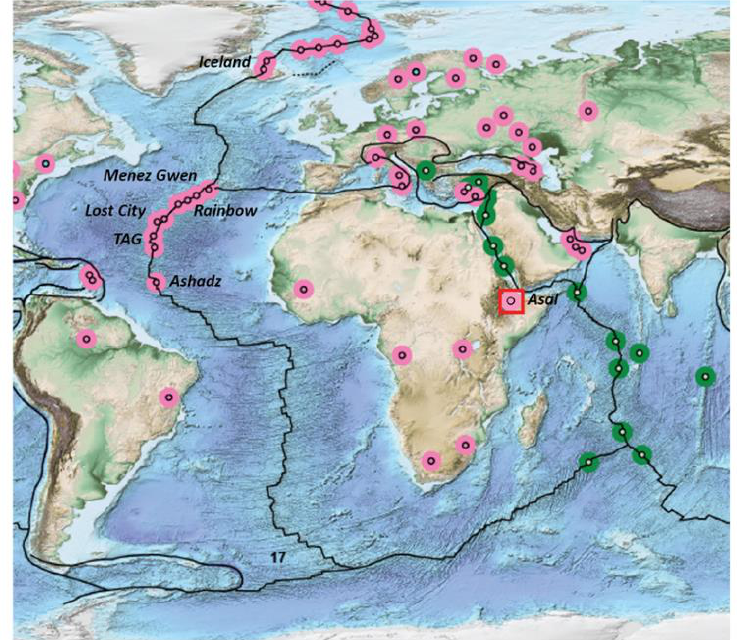
Figure 1. Map centered on the Atlantic Ocean, showing natural H 2 emissions (pink dots) and abiotic CH 4 emissions derived from H 2 (green dots). Locations of some smokers and of the study area (red square) are also shown. (Basemap modified from [2]).